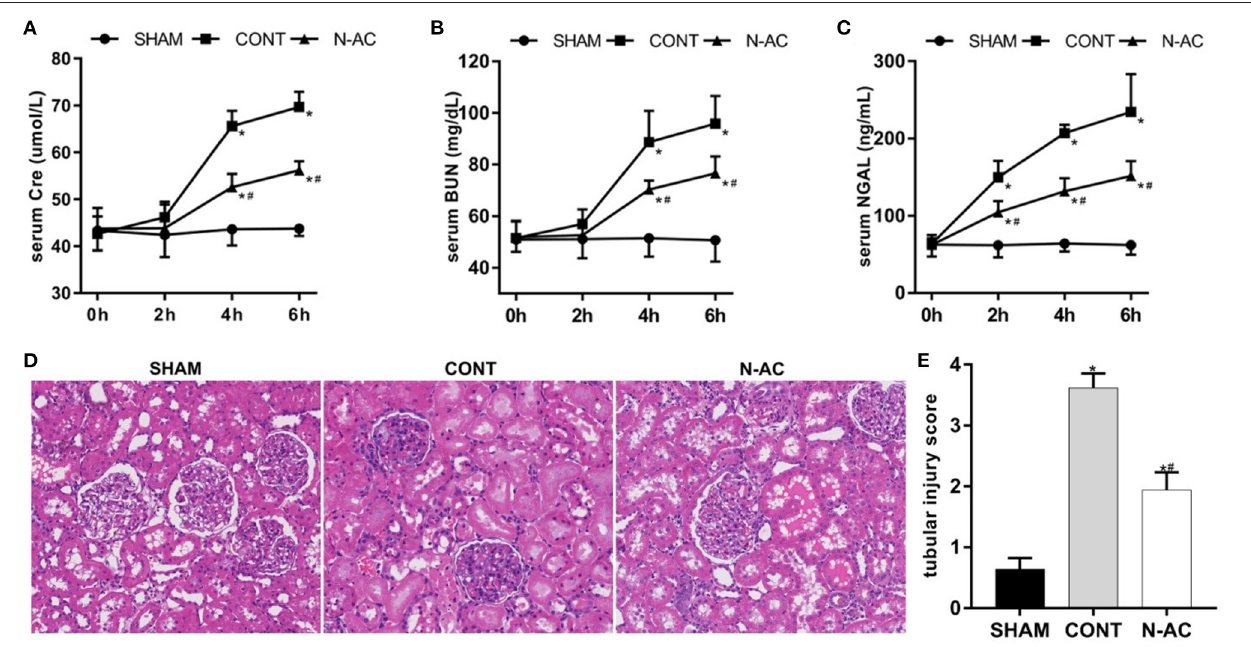
FIGURE 2 | N-AC alleviated renal dysfunction and pathological changes at 6h after ROSC. (A) The dynamic changes of serum creatinine (Scr) level after ROSC. (B) The dynamic changes of serum blood urea nitrogen (BUN) level after ROSC. (C) The dynamic changes of serum neutrophil gelatinase- associated lipocalin (NGAL) level after ROSC. (D) The renal pathological damage was evaluated by HE stains (400 × magnification). (E) Quantitative dates of TIS. SHAM, sham group; CONT, control group; N-AC, N-AC group. Sham group, n = 5; Control group, n = 7; N-AC group, n = 7. Data are expressed as mean ± SD. * P < 0.01, vs. sham group; # P < 0.01, vs. control group. SHAM, Sham group; CONT, Control group; N-AC, N-AC